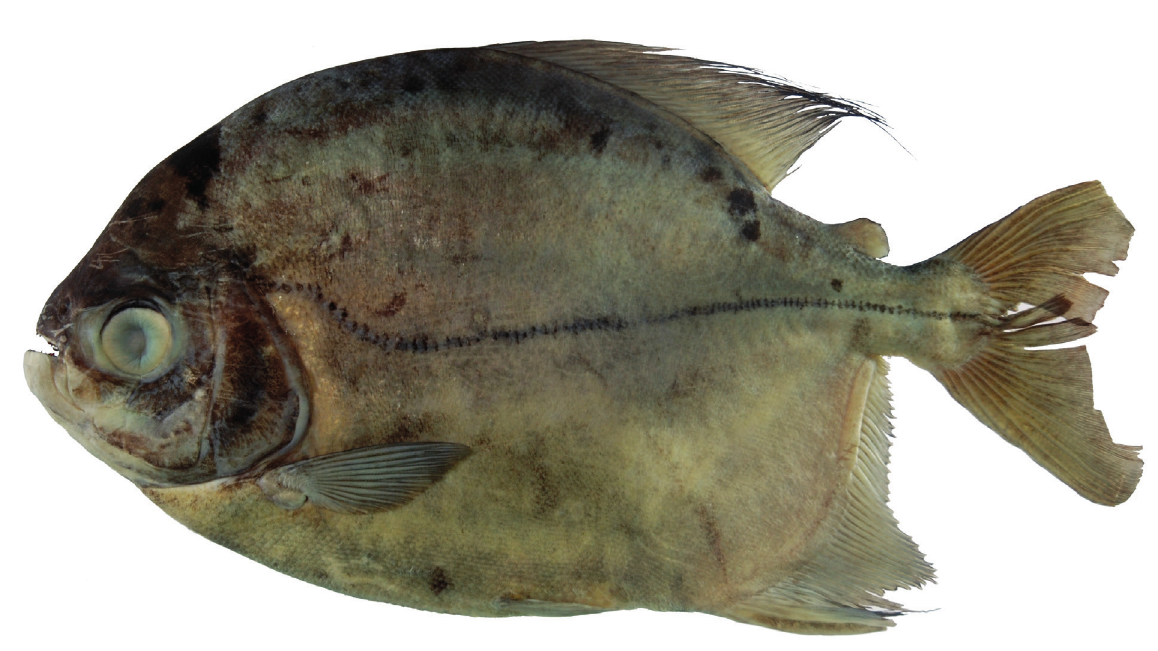
FIGURE 1 | Myloplus nigrolineatus, INPA 54773, holotype, 221.9 mm SL, male, lago Tracajá, tributary of rio Juma, ca . 60 km south of Manaus, Amazonas State,